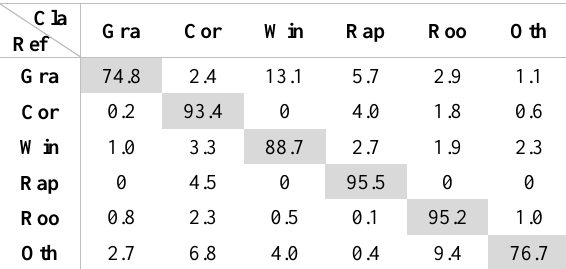
Table 1. Confusion matrix for CRF all -classification